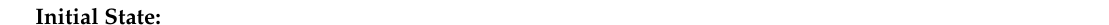
Table 1. Coalition formation